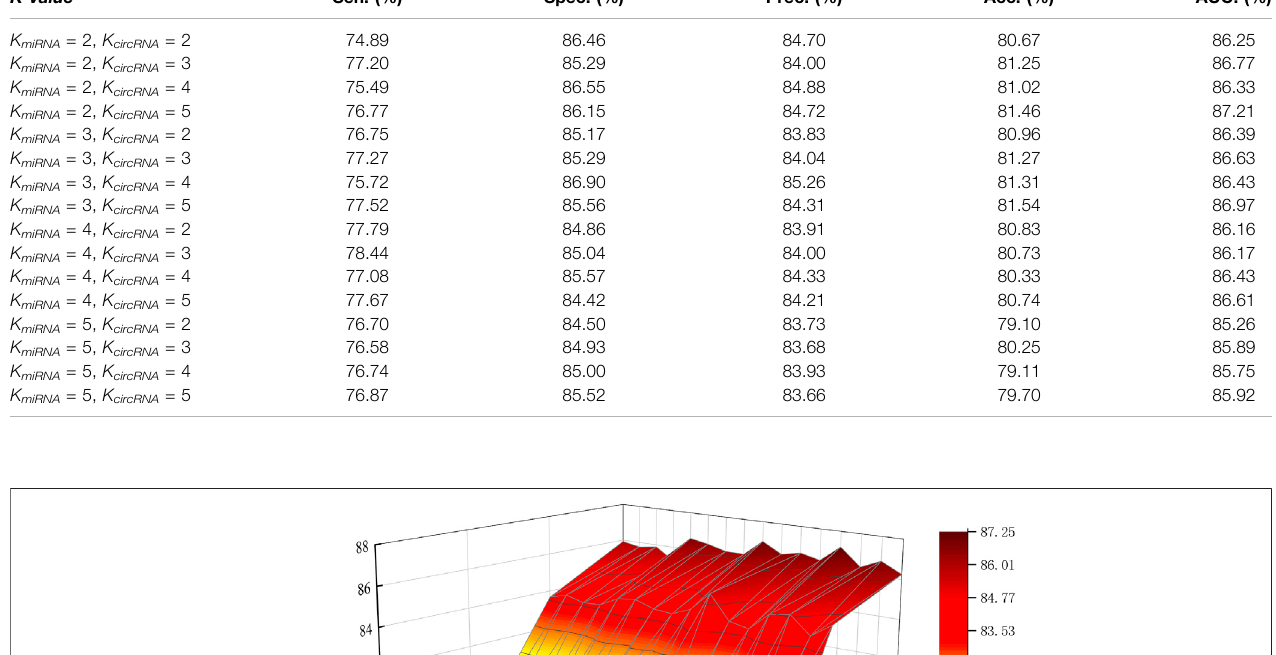
TABLE 3 | Performances of different K values. K-value Sen. (%) Spec. (%) Prec. (%) AUC. (%)